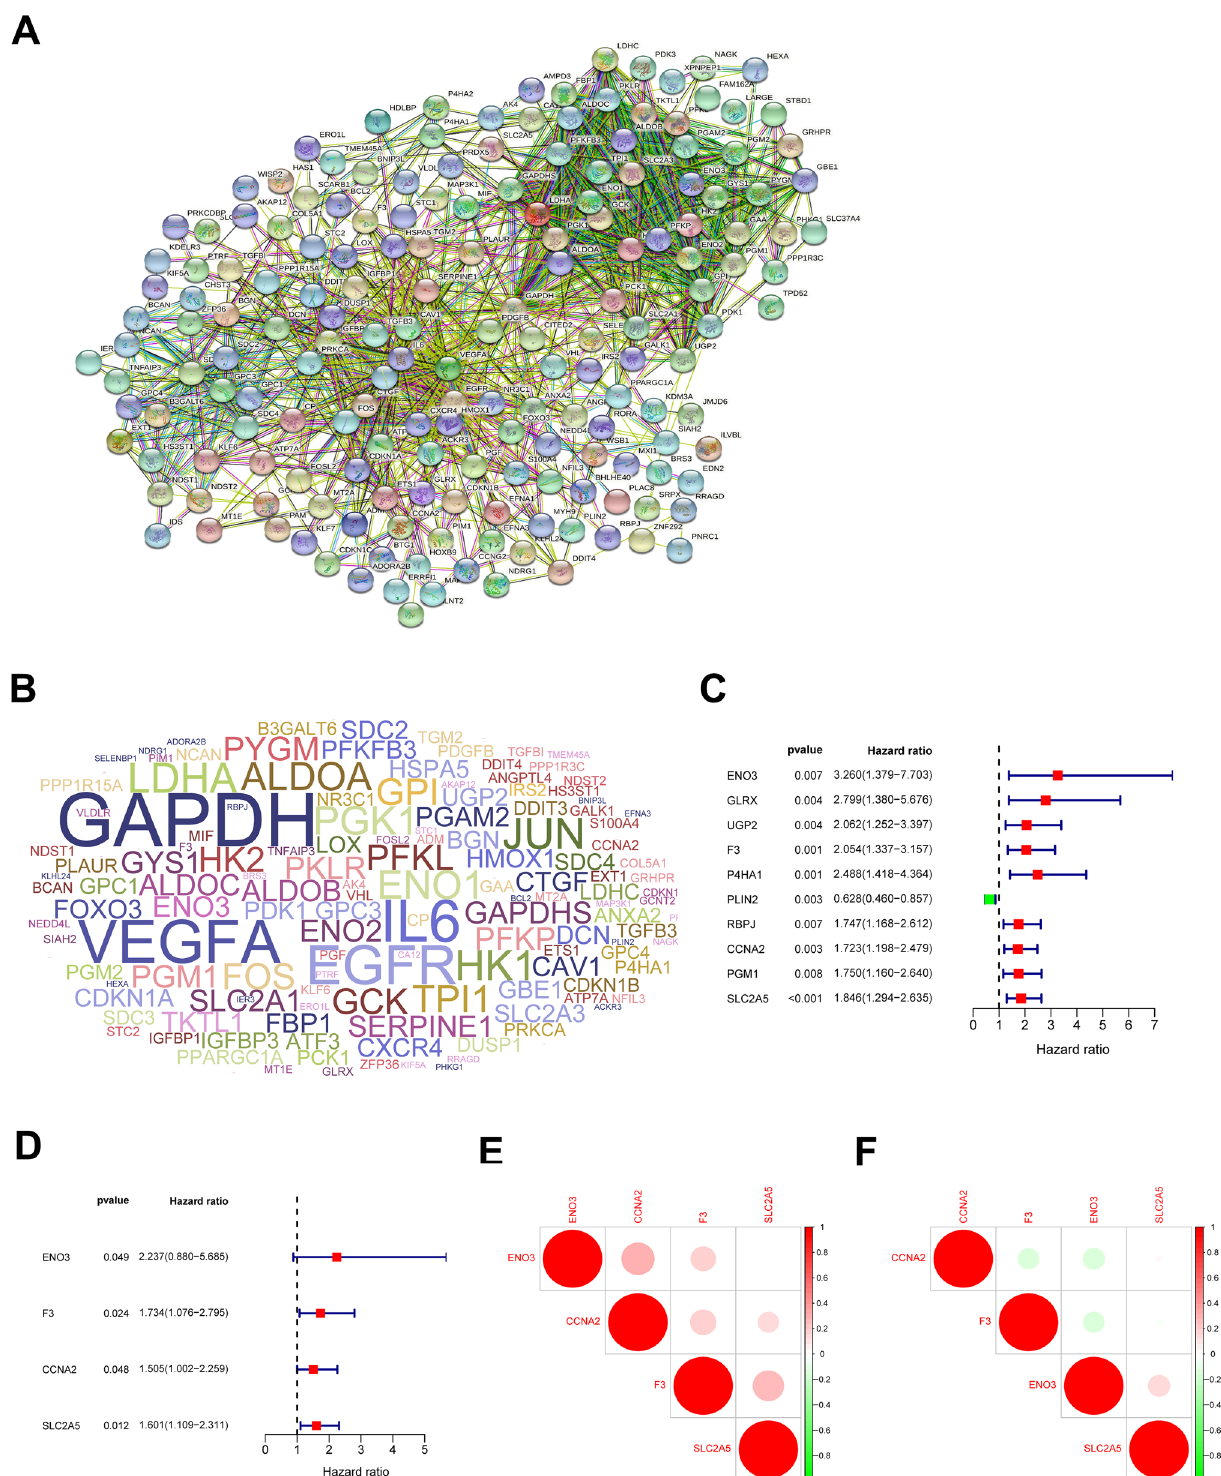
Figure 1. Construction of a hypoxia risk model to predict the clinical prognosis of childhood AML. ( A ) Interaction relationships among hypoxia-associated genes via STRING database; ( B ) Word frequency cloud of the top 150 hypoxia-associated genes, where the size of the gene name represented its node degree; ( C , D ) Screening of hypoxia-related genes by univariate and multivariate Cox regression analyses to construct a hypoxia risk model with prognosis predictive value; ( E , F ) Spearman correlation analysis for the identified four hypoxia-associated genes involved in the risk signature in the TARGET and GEO